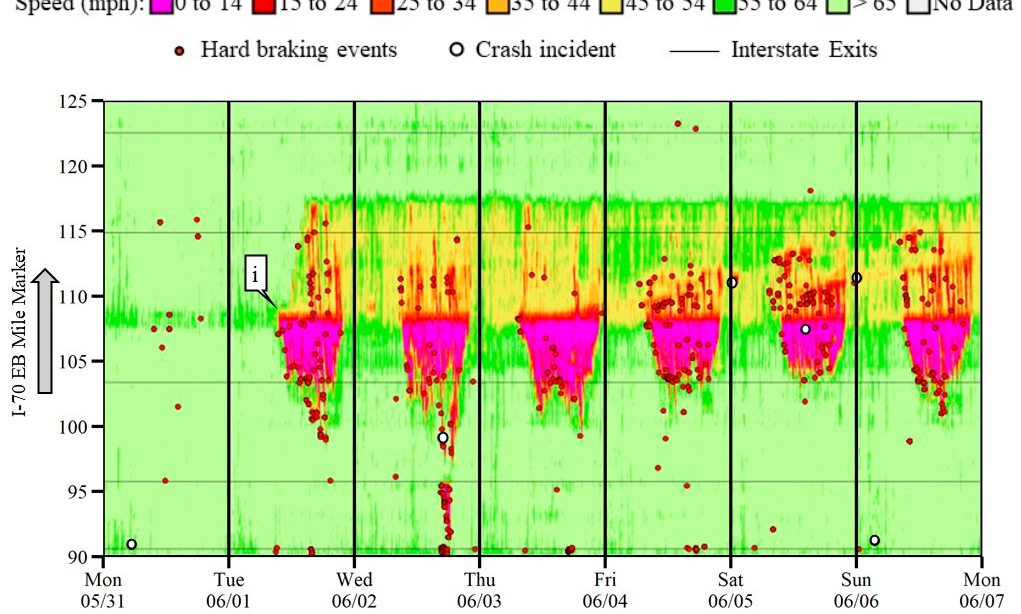
Figure 13. Traffic speed heatmap for I-70 EB (MM 90–MM 125) for the week of 31 May.